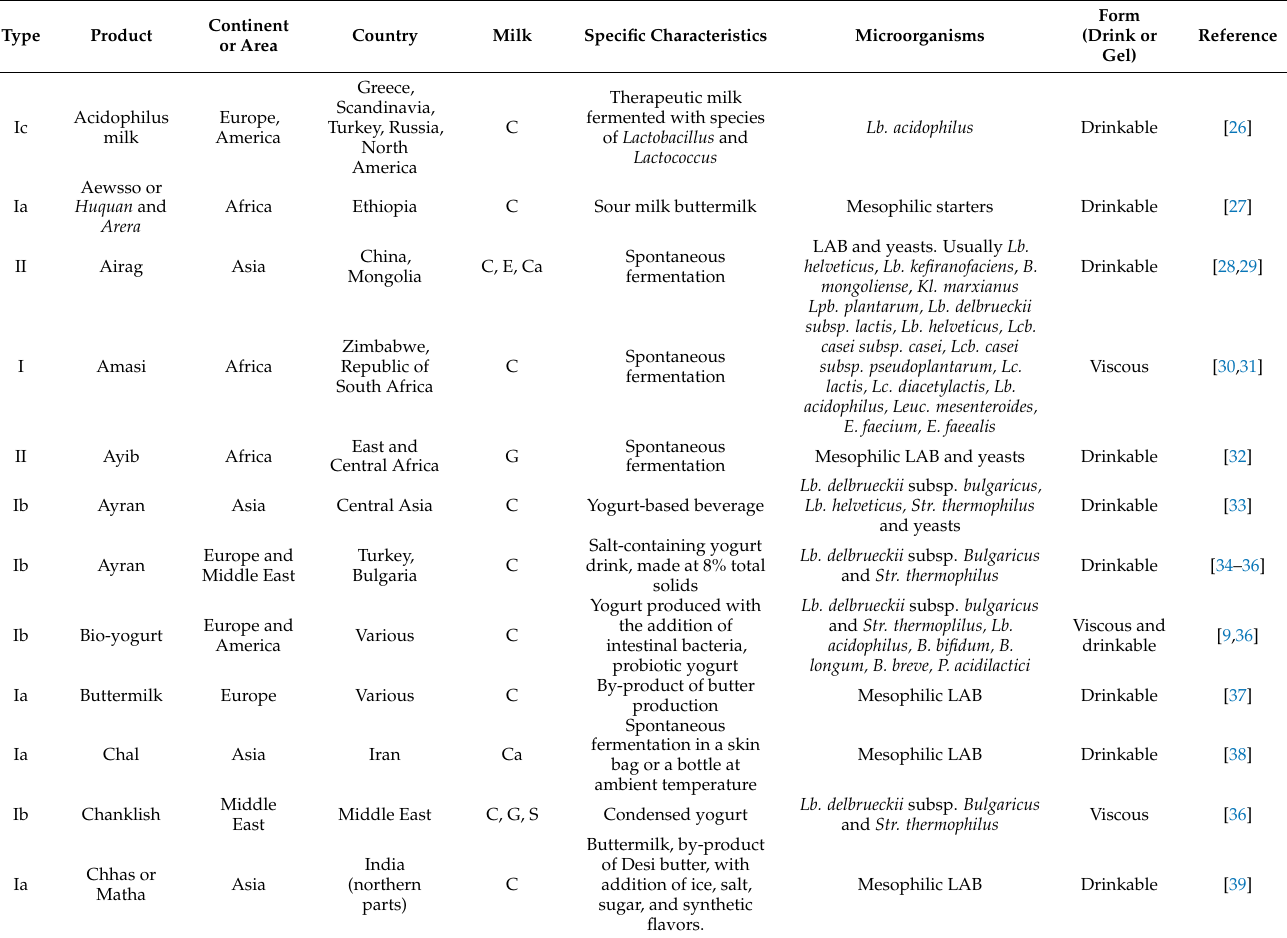
Table 2. Specific and microbiological characteristics of some traditional fermented milk